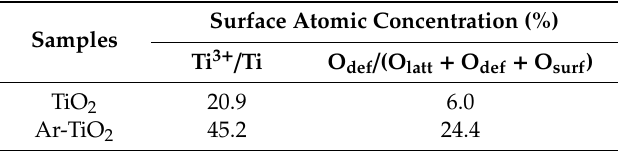
Table 1. Surface atomic species on the surface of TiO 2 and Ar-TiO 2 catalysts.